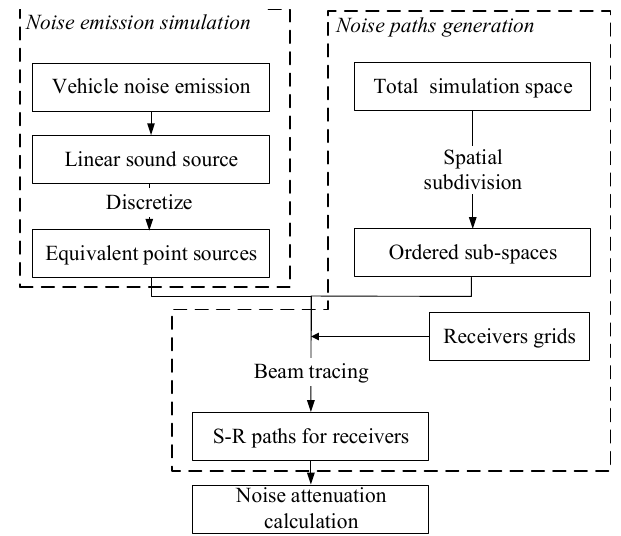
Figure 1. Overview of the noise calculation approach among buildings.